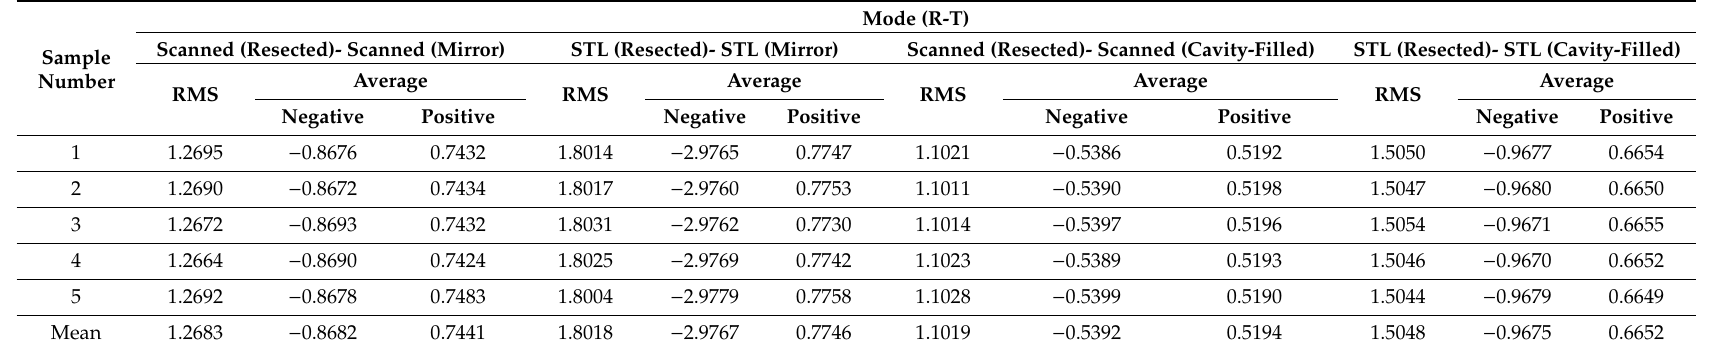
Table 1. The 3D comparison results of the mirror and the cavity-filled reconstruction